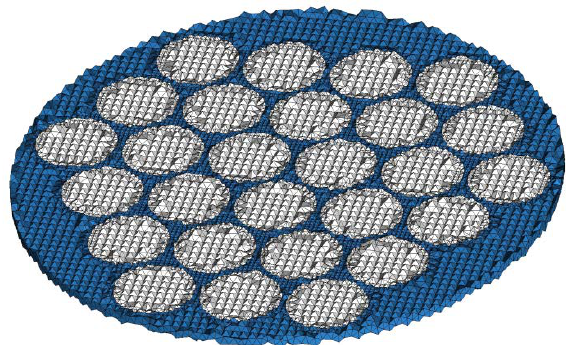
Figure 4. Cross-section of a computational mesh of a model with detailed geometry.